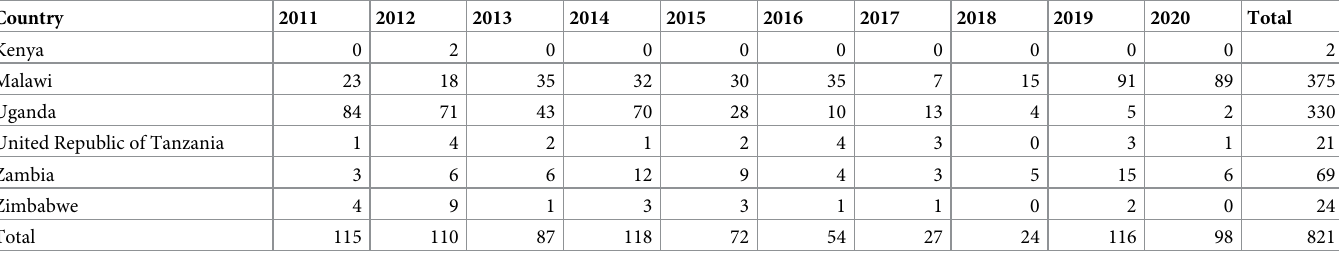
Fig 2 shows the geographical distribution of sleeping sickness cases in Africa during 2019– 2020. Green dots mark the location of active screening activities where no cases were detected. S1 File provides larger-scale subregional maps. Table 2. T . b . rhodesiense HAT: new cases reported between 2011 and